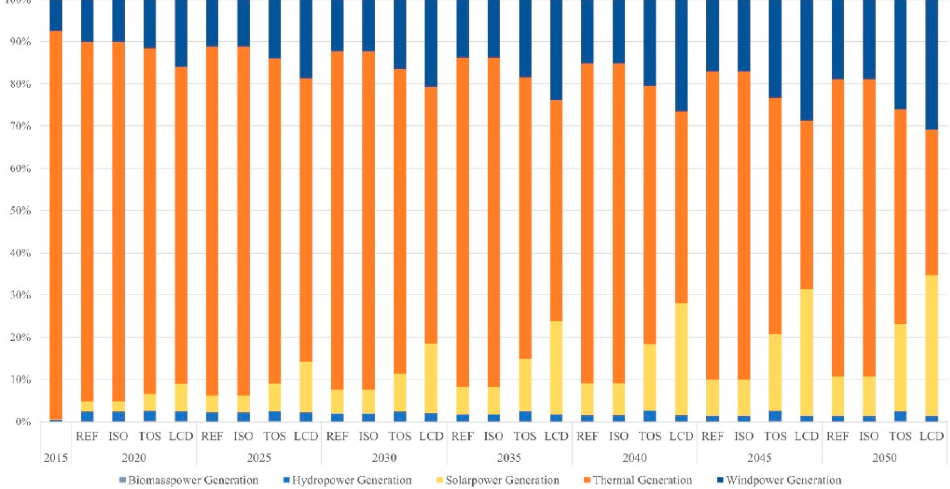
Figure 6. Proportion of the electricity generation mix by 2050 in the four scenarios.